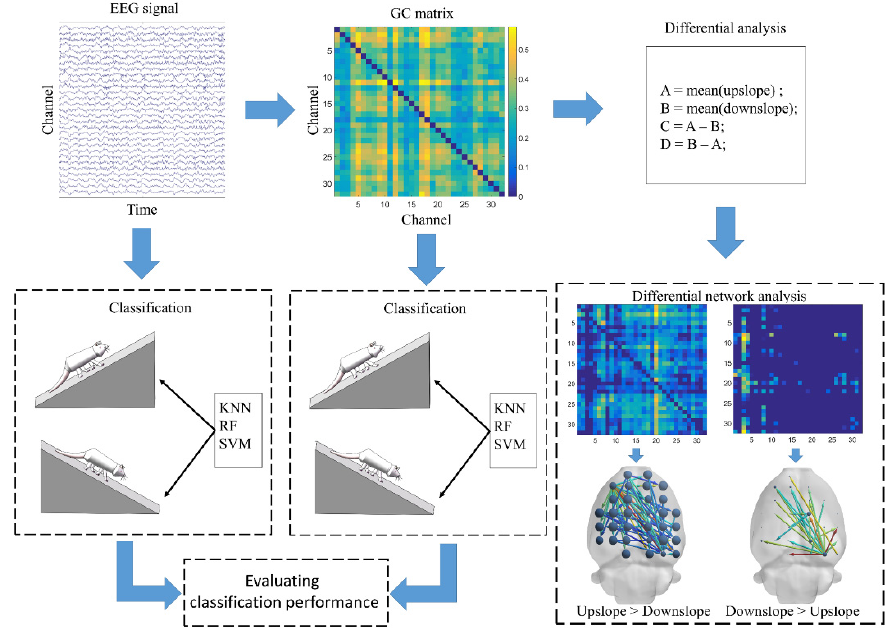
Figure 2. Schematic of electroencephalography (EEG) data processing flow.